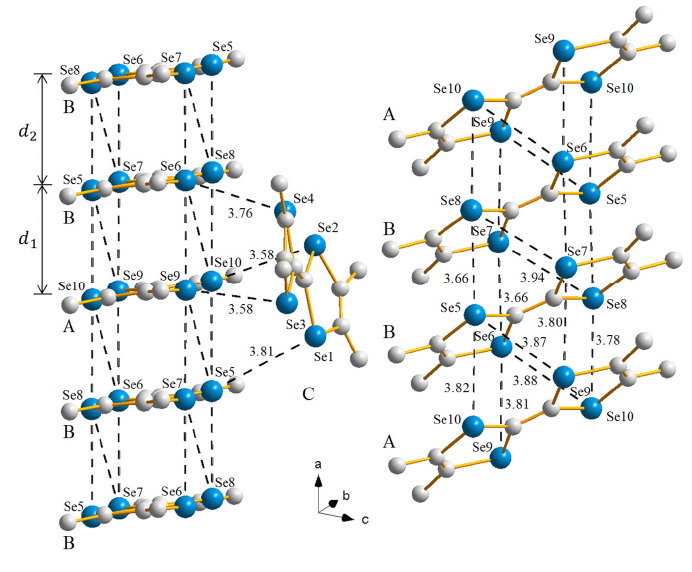
Figure 6. Donor arrangement in (TMTSF) 5 (I 3 ) 2 . Hydrogen atoms are not shown for clarity. The crystallographically independent TMTSF molecules are labeled A, B, and C, respectively. The broken lines show the Se · · · Se contacts shorter than the sum of van der Waals radii of two Se atoms (4.0 Å). The interplanar distance between A and B is d 1 = 3.45 ( 3 ) Å; and that between B and B is d 2 = 3.39 ( 4 ) Å,